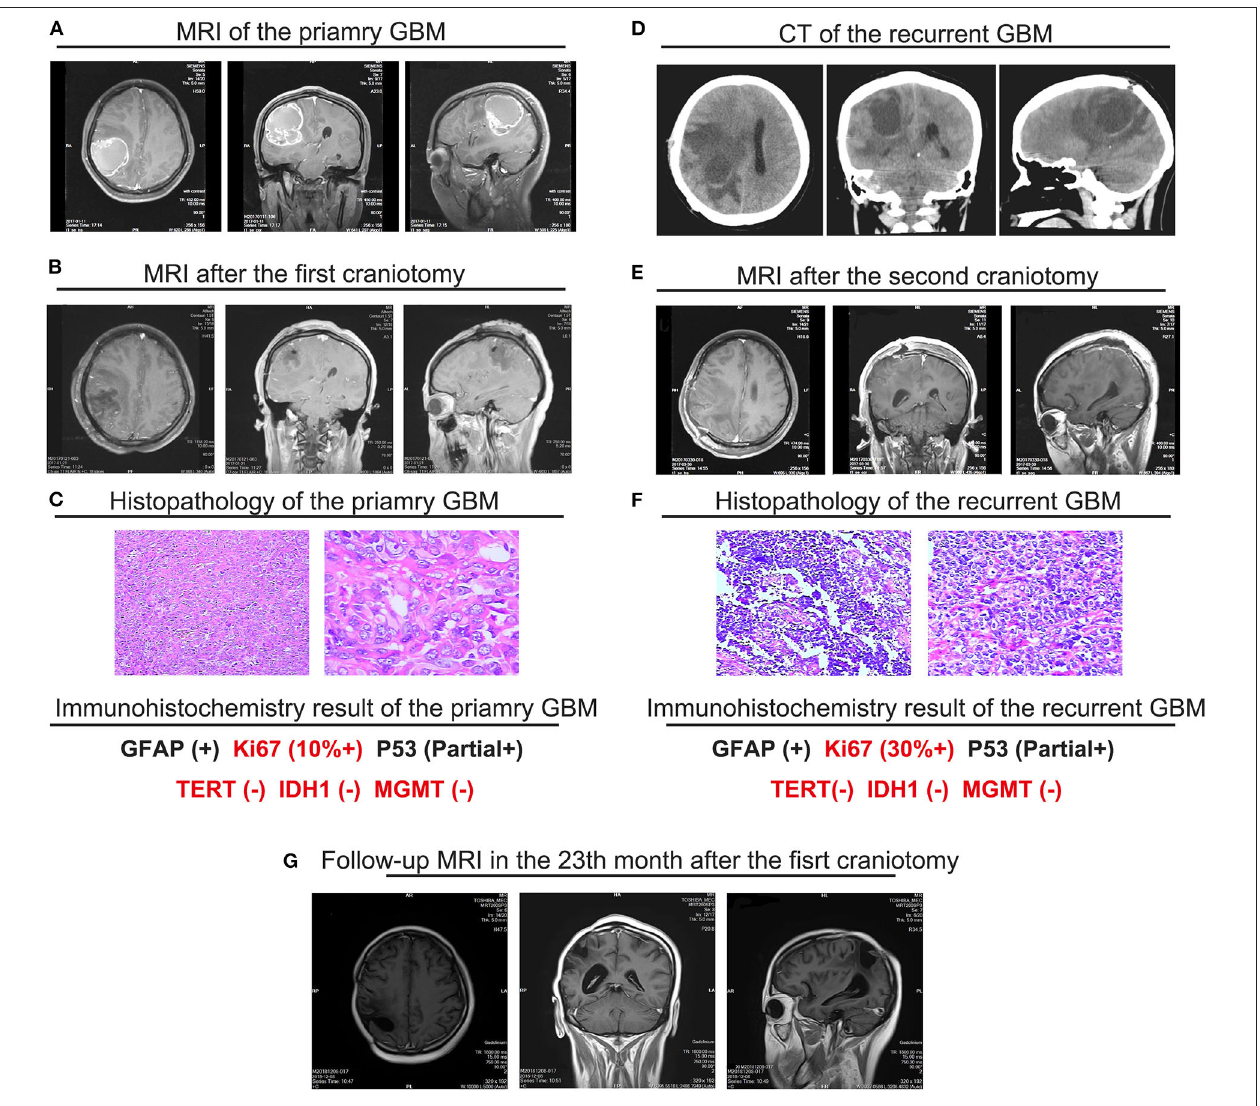
FIGURE 1 | Main medical imaging and histopathology information of the pregnant GBM patient. (A) MRI images of the primary GBM prior to the first right parietal craniotomy that demonstrated a heterogeneous cystic and solid mass in the right parietal lobe with marked surrounding edema and a shift of the midline structures to the left side (01/11/2017). (B) MRI images on the 3rd day after the first right parietal craniotomy that demonstrated a total resection of the mass, the marked surrounding edema and a shift of the midline structures to the left side remained (01/21/2017). (C) Histopathological features of the primary GBM. Hematoxylin and eosin (H & E) staining of the primary revealed the hyper-cellular astrocytic neoplasm. The features such as mitotic activity, microvascular proliferation, and pseudopalisading presented. The histopathological features indicated the primary tumor to be GBM. (D) Emergency CT scan when the patient was diagnosed with a recurrent tumor, prior to the second right parietal craniotomy which demonstrated a huge fresh mass of low density in the right parietal lobe surrounded by extensive edema, accompanied with a shift of midline structure and distortion of the right lateral ventricle (03/28/2017). (E) MRI images on the 3rd day after the second right parietal craniotomy which demonstrated a total resection of the recurrent tumor, the marked surrounding edema and a shift of the midline structures to the left side still remained (03/30/2018). (F) Histopathological features of the recurrent GBM. Hematoxylin and eosin (H & E) staining of the primary revealed the similar histopathological features with the primary tumor. (G) MRI images of the latest follow-up after multidisciplinary therapy (12/08/2018). The images demonstrated no signs of recurrence and smaller volume of the surrounding edema. The region of the tumor transformed into a capsule without enhancement. The disease remained stable.